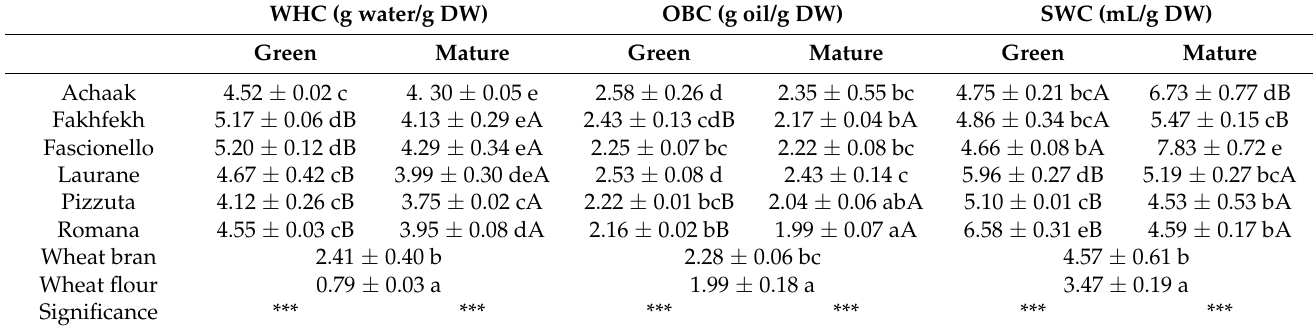
Table 3. Values of water-holding capacity (WHC), oil-binding capacity (OBC), and swelling capacity (SWC) of AH powders, wheat bran, and wheat flour, and results of variance analysis with Duncan’s test ( p < 0.05) performed between the products and the two harvesting times (green and